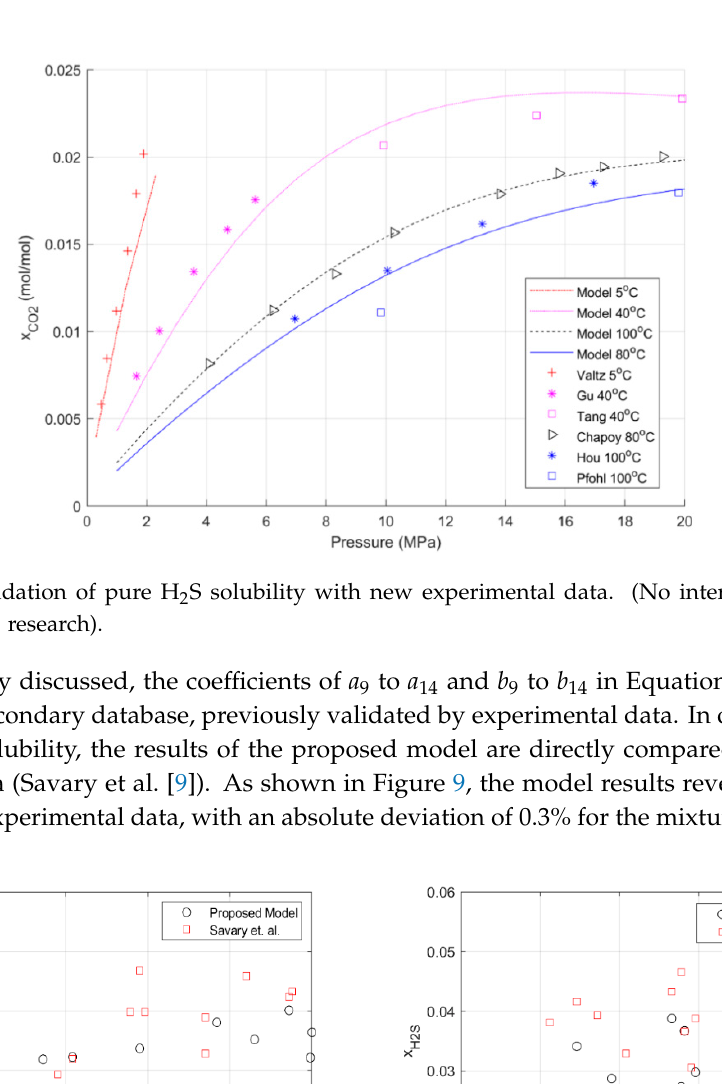
Figure 10. Geothermal case study: effect of H 2 S on the solubility of CO 2 (Temperature: 89 °C). To better understand how this deviation in the estimation of solubility may influence the design, the relative solubility error ( (cid:1857) (cid:3045) ) is calculated according to equation 10: